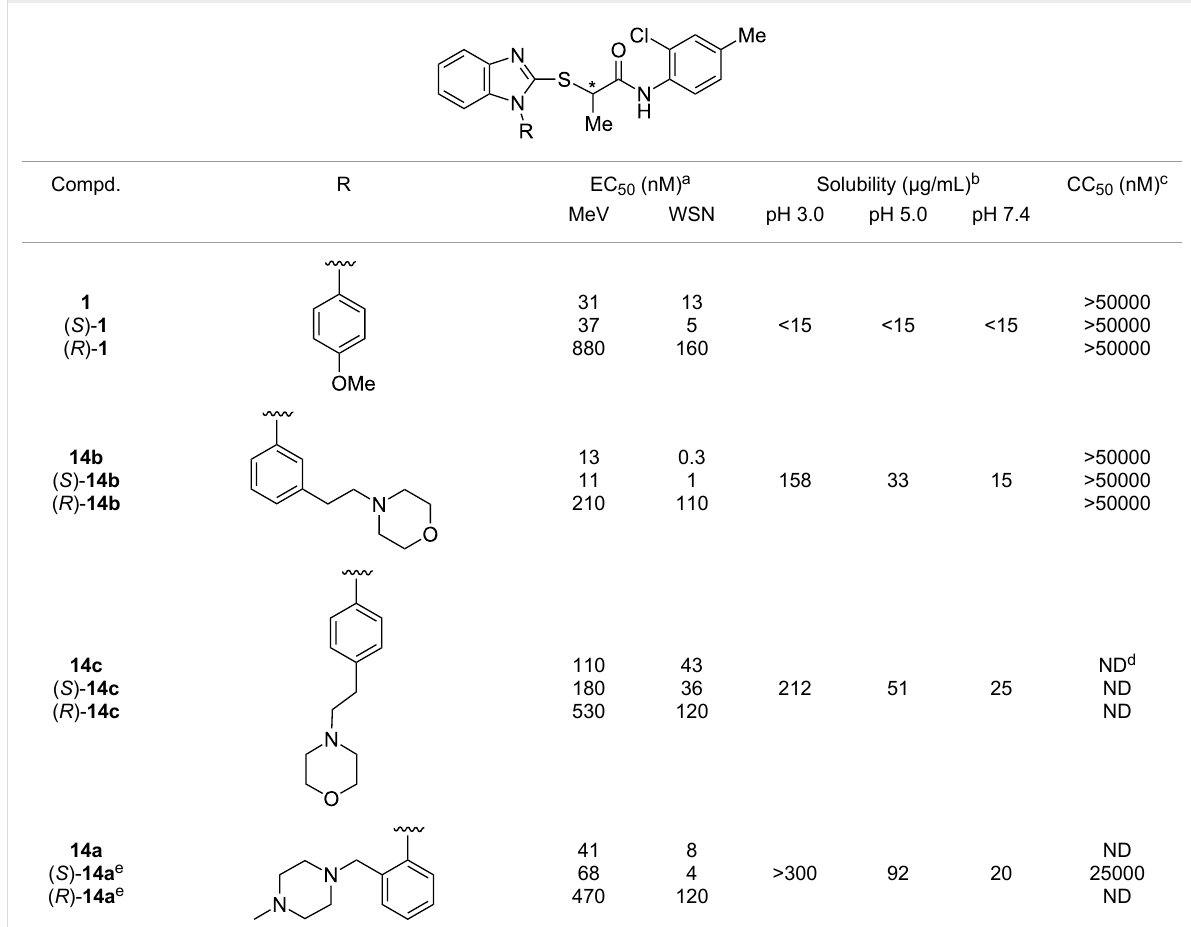
Table 2: Antiviral potencies and solubilities for 1 and analogues.